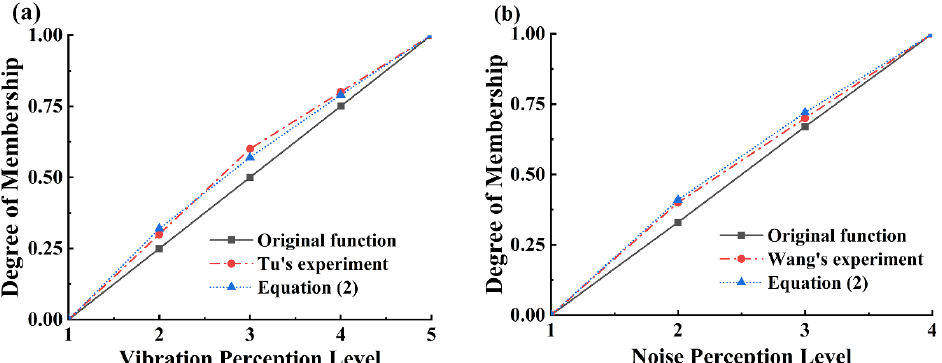
Figure 1. Comparisons of the original membership function, Equation (2), and the experimental results of vibration and noise: ( a ) comparing functions with Tu’s experiment about vibration; ( b ) com- paring functions with Wang’s experiment about noise. (Two pictures were drawn according to Tu and Wang’s perception experiment